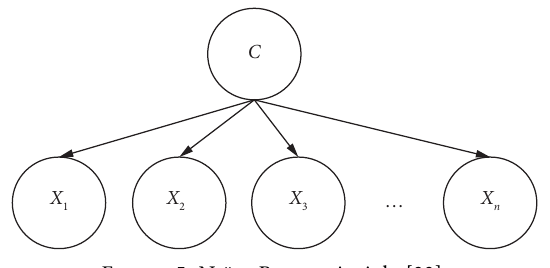
Figure 4: Sigmoid function curve [20].